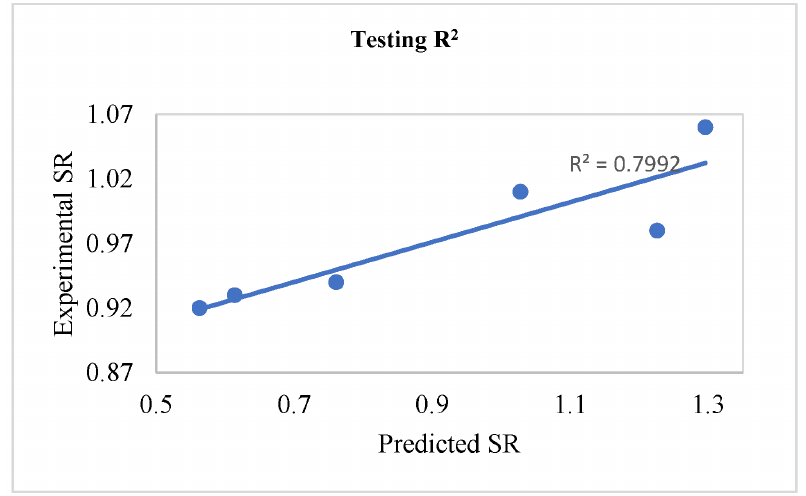
Figure 13. ANN-PSO regression line for testing.